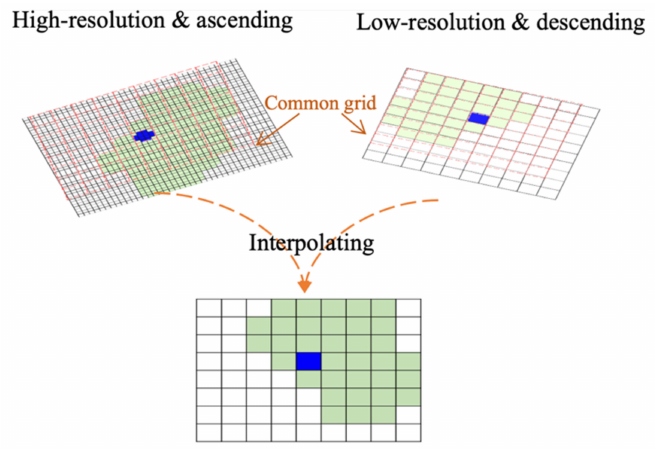
Figure 3. Schematic diagram of interpolating the multiplatform SAR interferogram to a common georeferenced